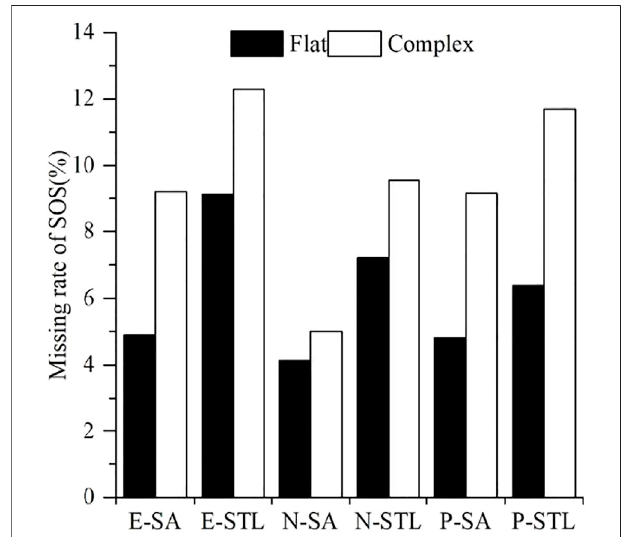
FIGURE4| Comparison ofmissing ratesofSOS over the fl at terrain and the complex